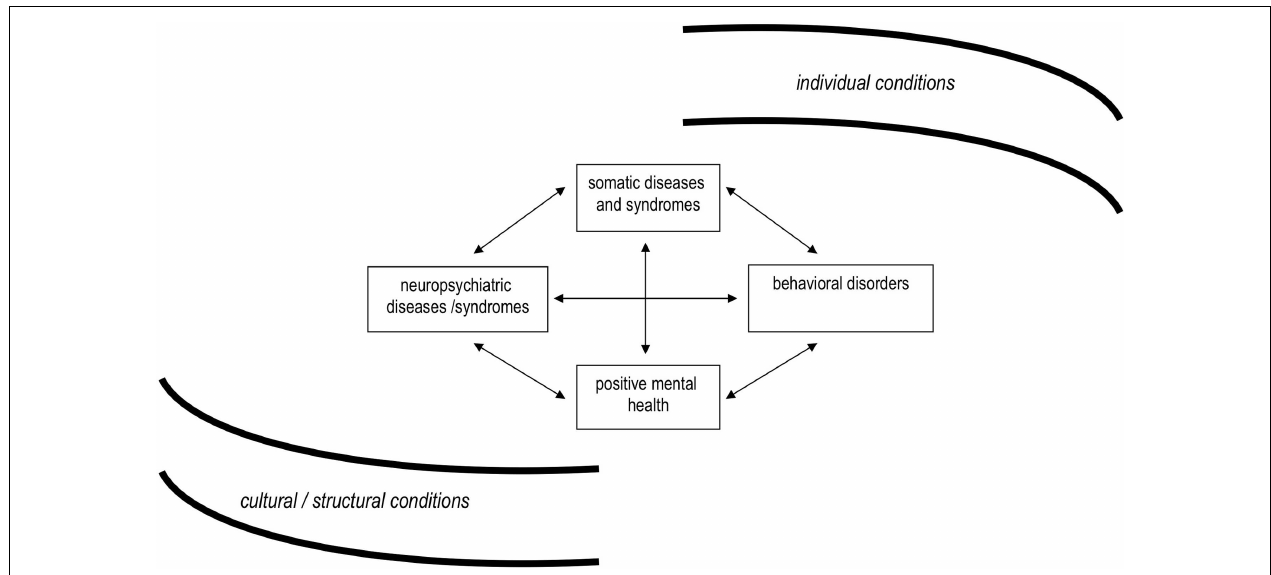
FIGURE 1 | Components of a general model of health / public health